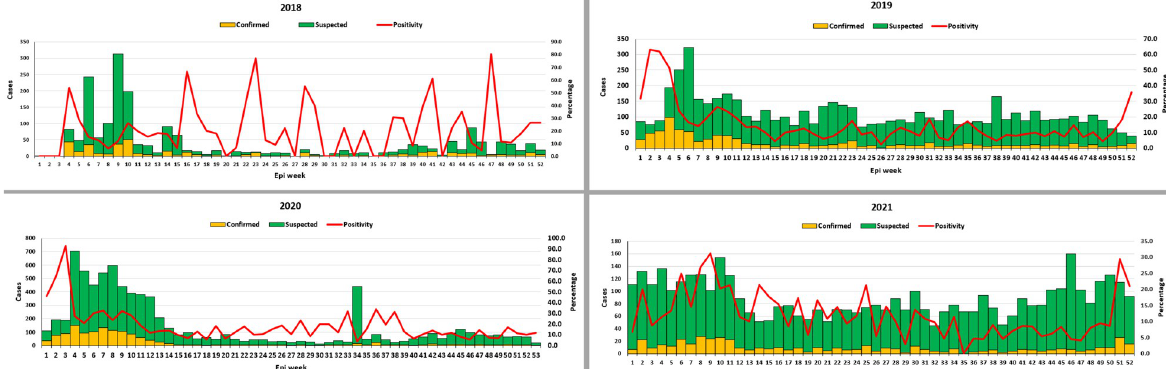
Fig 2. Trend of weekly distribution of Lassa fever suspected and confirmed cases as well as the test positivity rates, Nigeria, 2018–2021.